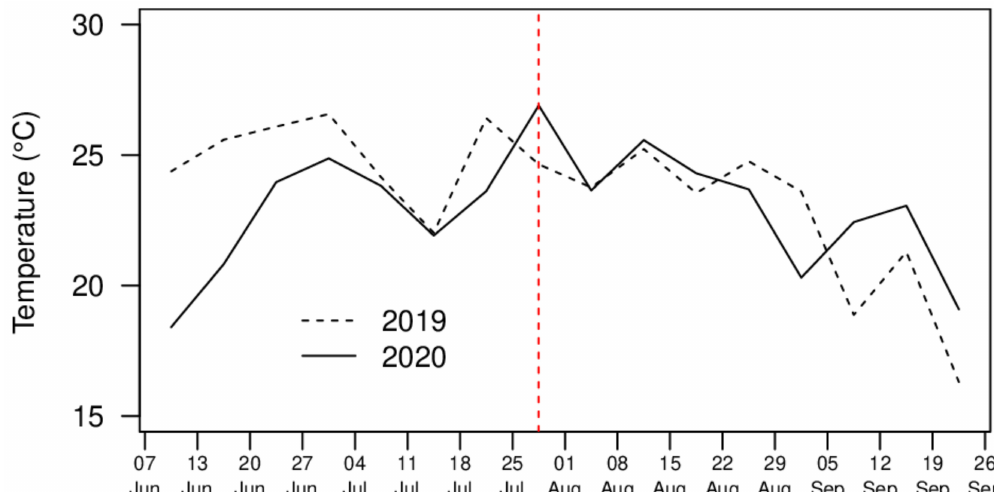
Figure 1. Weekly mean air temperatures in a rain-out structure in Legnaro (Padua, North-Eastern Italy) during the experimental periods of 2019 (June–August) and 2020 (June–September). The red vertical line indicates when the date irrigation recovery began (29th July 2019, 28th July